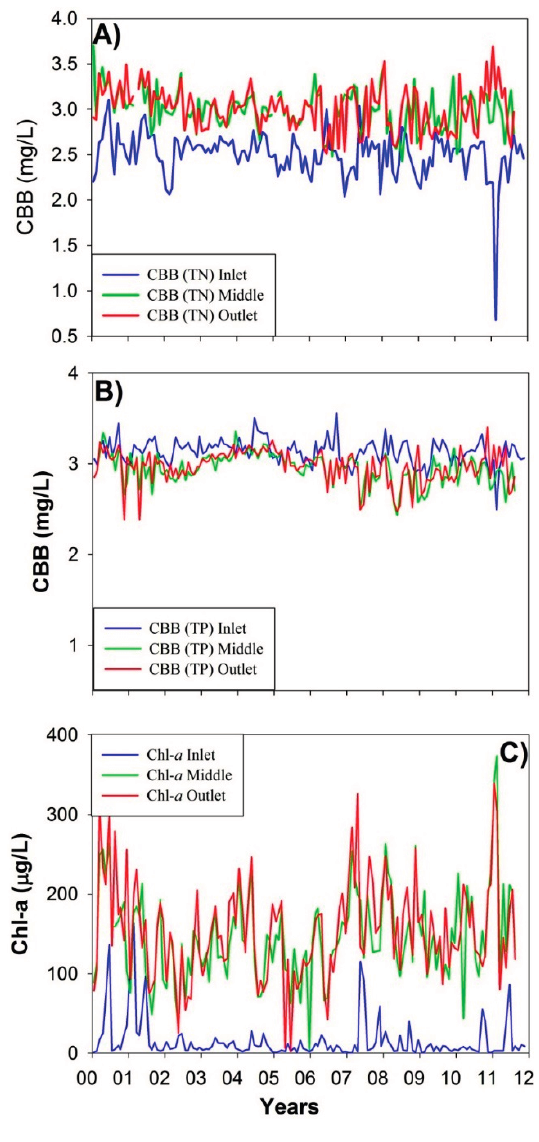
Figure 3. Time series of cyanobacteria biomass (CBB) estimations from ( A ) TN and ( B ) TP at the three sampling points, ( C ) data on measured chl-a